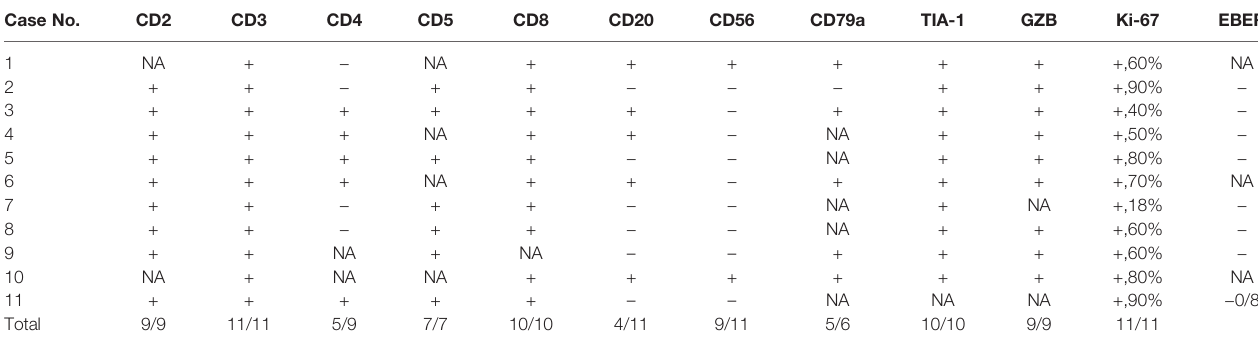
TABLE 2 | Immunohistochemical features of the 11 cases with subcutaneous panniculitis-like T-cell lymphoma. Case